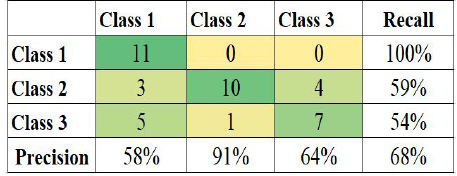
Figure 6. Haiti classifier scored the highest accuracy of 68%. Class 1 and class 2 samples are predicted correctly; wheres class 3 samples have maximum misclassified predictions. Class 1 has 100% recall